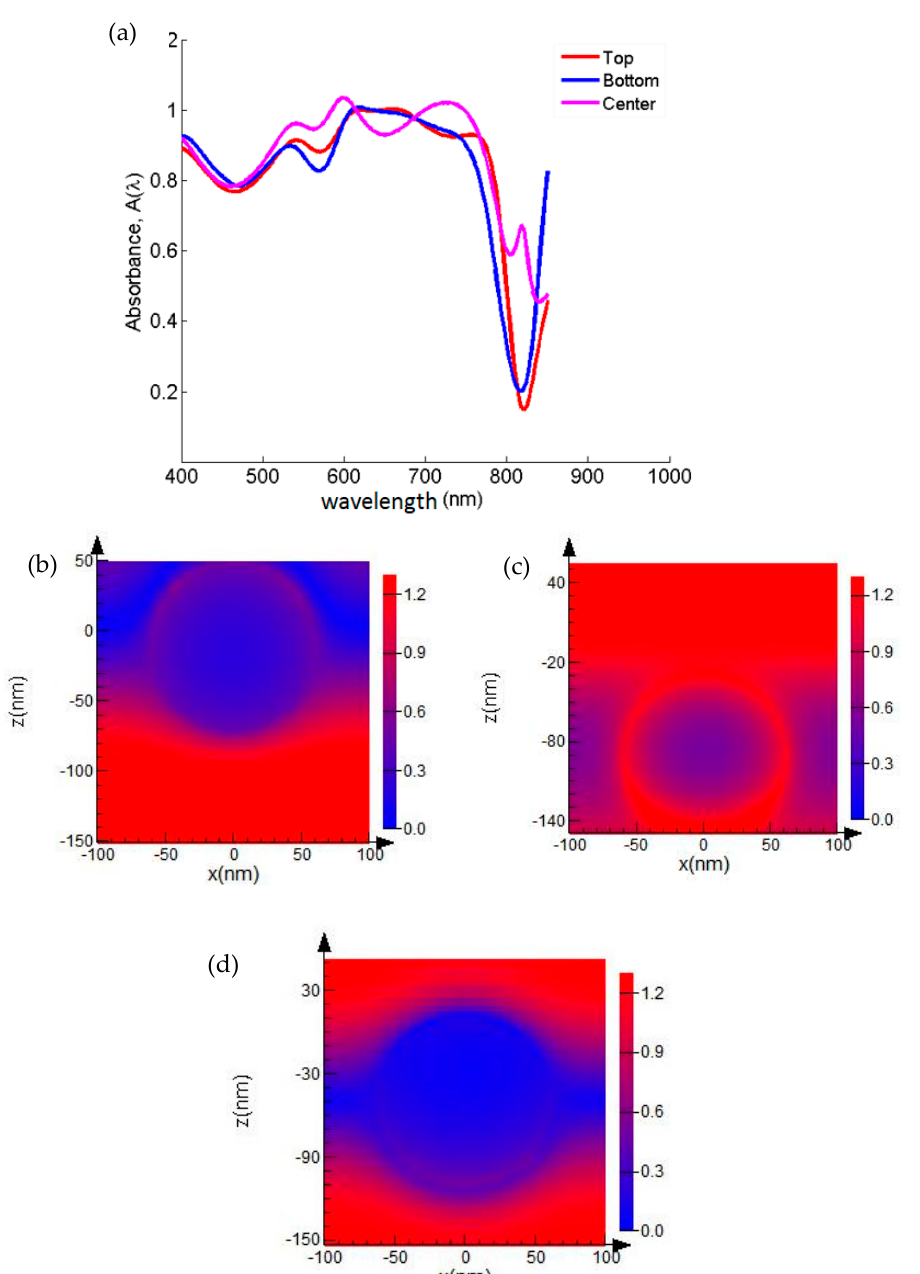
Figure 4. ( a ) The absorbance spectra of the PSC including an NP with a radius of 60 nm situated in different spots in the direction of the light source. ( b – d ) The electric field distribution spectra related to the locations of top, bottom, and center of the absorber layer.